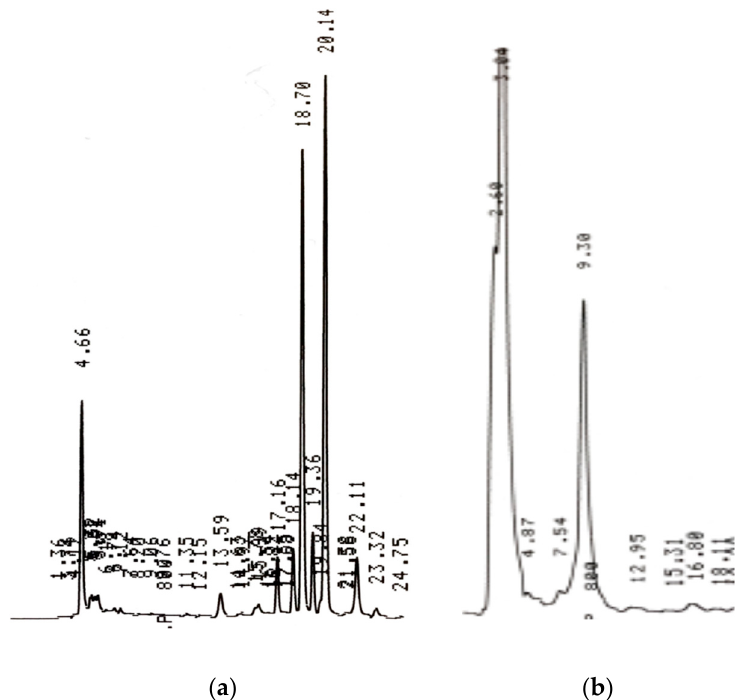
Figure 1. High–performance liquid chromatography ( HPLC) chromatograms of the extracted coffee sample. ( a ) Displaying peaks for trigonelline, 5–CQA, caffeine and mangiferin at 4.66, 18.70, 20.14 and 22.11 min, respectively, obtained using an ultra–violet ( UV) detector at 270 nm; ( b ) displaying sucrose peak at 9.30 min obtained using a refractive index (RI)